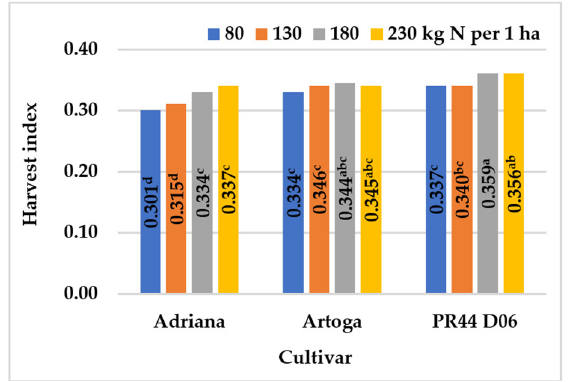
Figure 9. The effect of N rate on the harvest index of winter oilseed rape cultivars, across years. Means